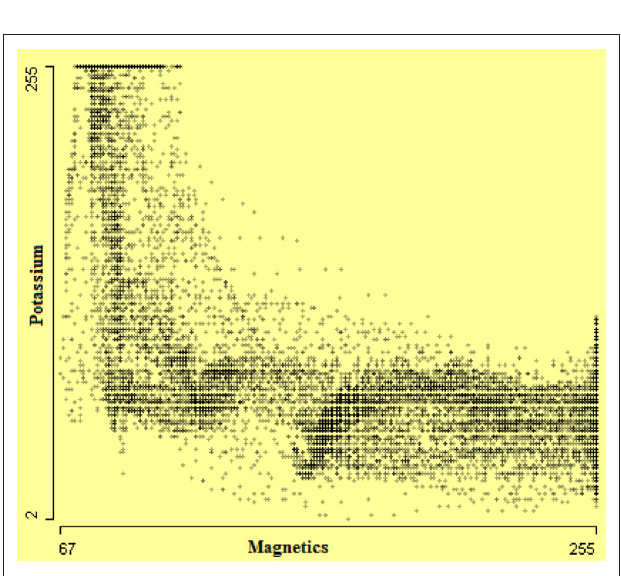
FIgurE 10 | Scatterplot of Potassium by Magnetics